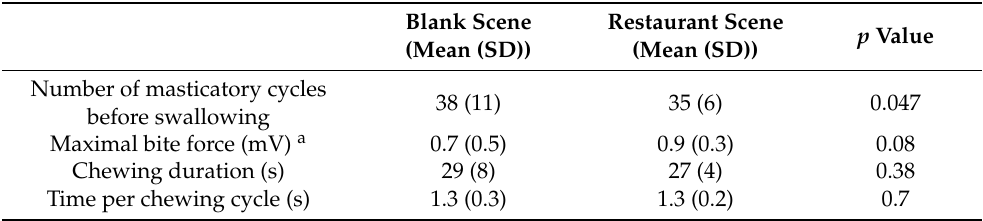
Table 2. Masticatory parameter data in the blank scene and restaurant. N = 15 for all measurements in both the blank and restaurant scene.